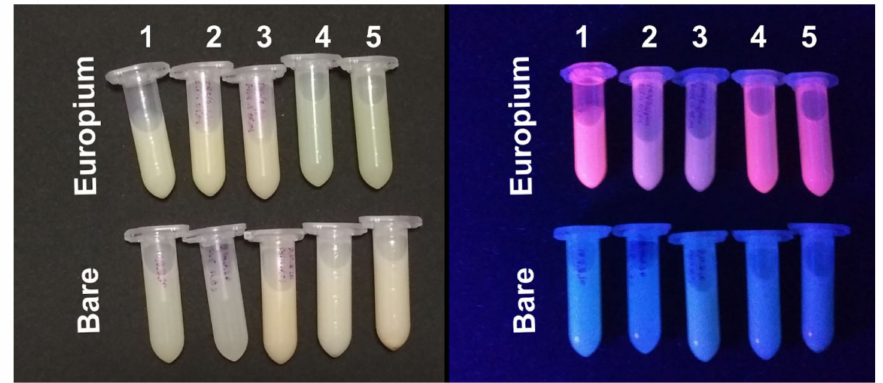
Figure 8. Gelatin nanoparticles containing and not containing europium complexes at daylight ( left ) and in UV light (360 nm, right ). Nanoparticles were prepared from gelatin: 1—B, 75 bloom; 2—B, 225 bloom; 3—FISH; 4—A, 62 bloom; 5—A, 180